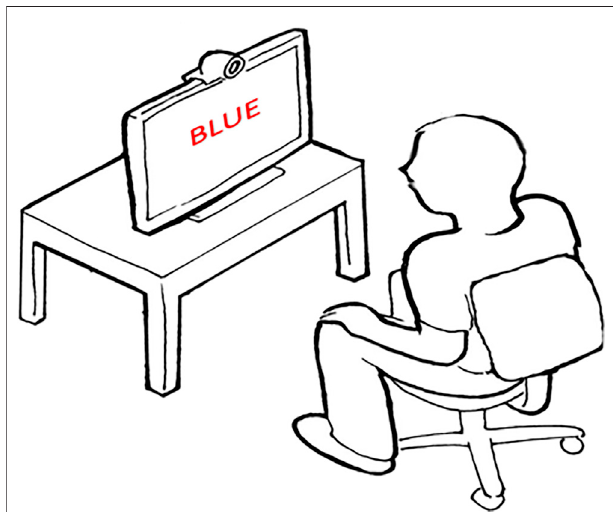
FIGURE 1 | Example of a 2D computerized